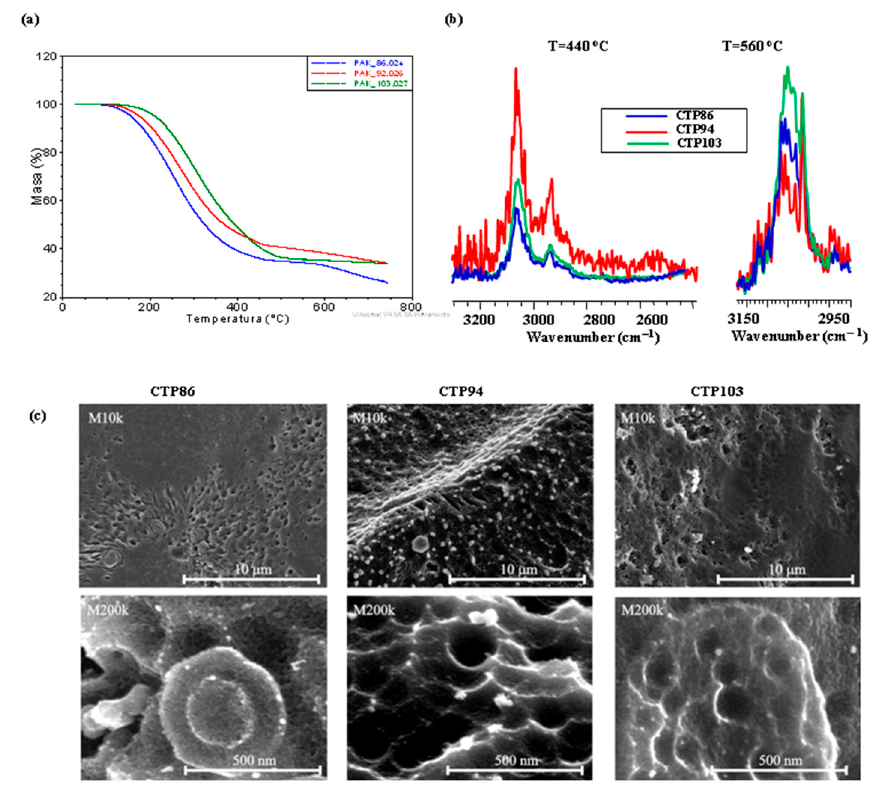
Figure 12. Results of pyrolysis of CTPs: TGA curves of CTPs: ( a ); fragments of normalised FT-IR spectra of volatile products mitted from CTPs at the pyrolysis temperatures of 440 °C and 560 °C ( b ); SEM images of the relief of pyrolyzed CTPs at a temperature of 750 °C ( c ).